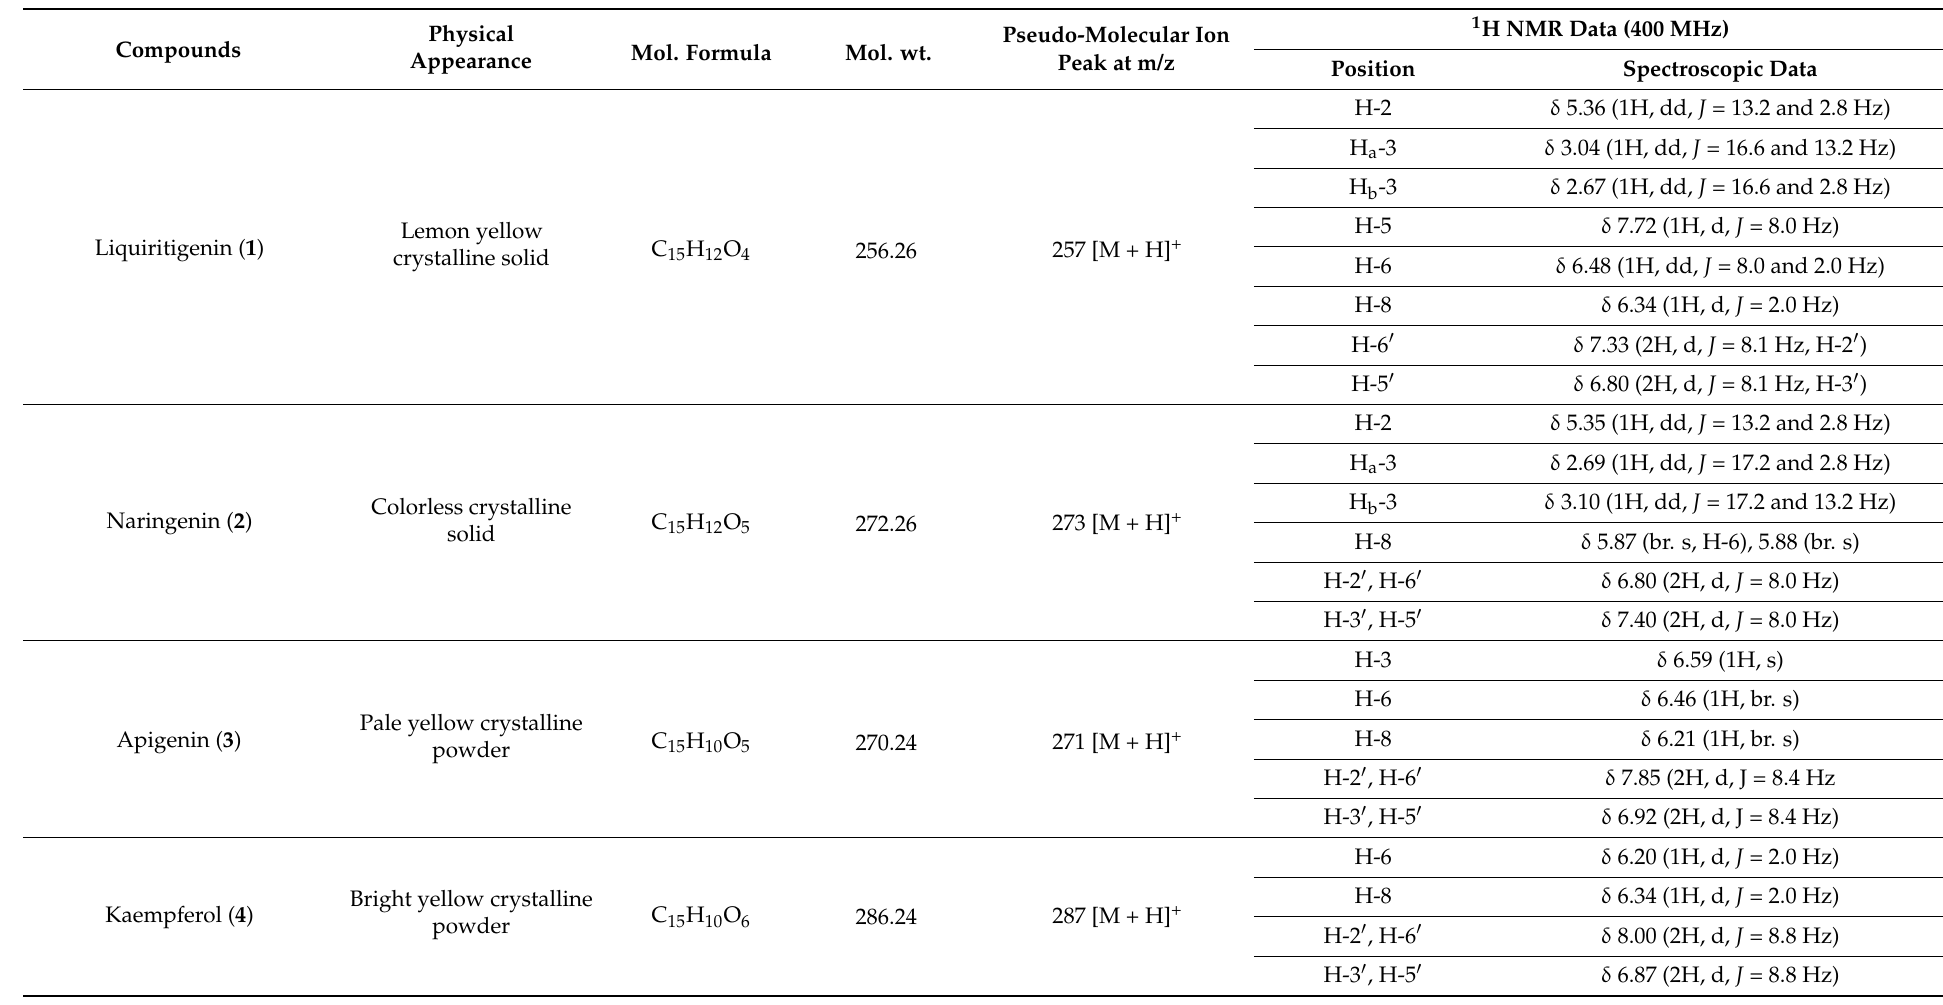
Table 1. The 1 H NMR (400 MHz, CD 3 OD) and ESI mass spectroscopic data of the isolated compounds 1 – 8 from W. tinctoria